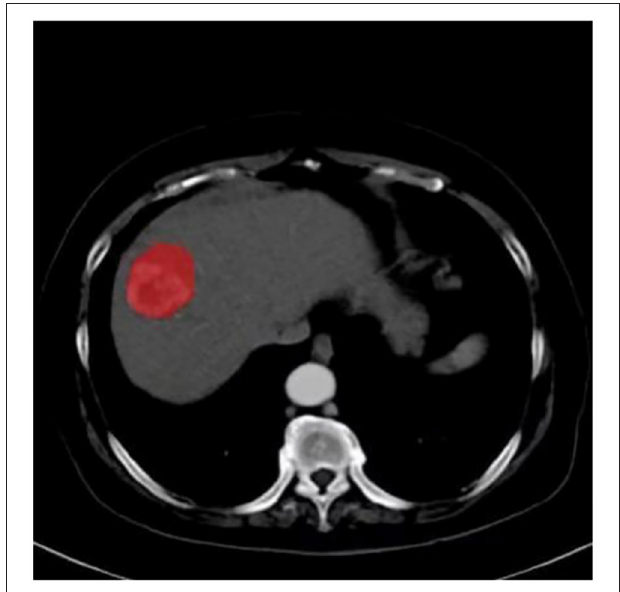
FIGURE 3 | Lesion segmentation for radiomics